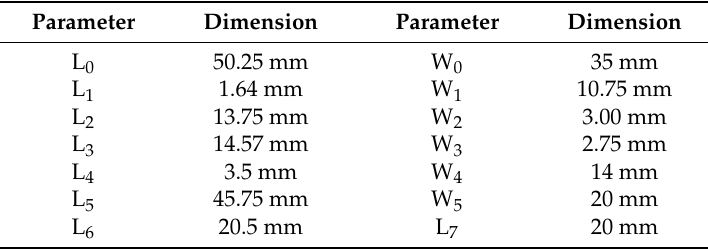
Table 2. L 6 and L 7 dimensions for unique identification.